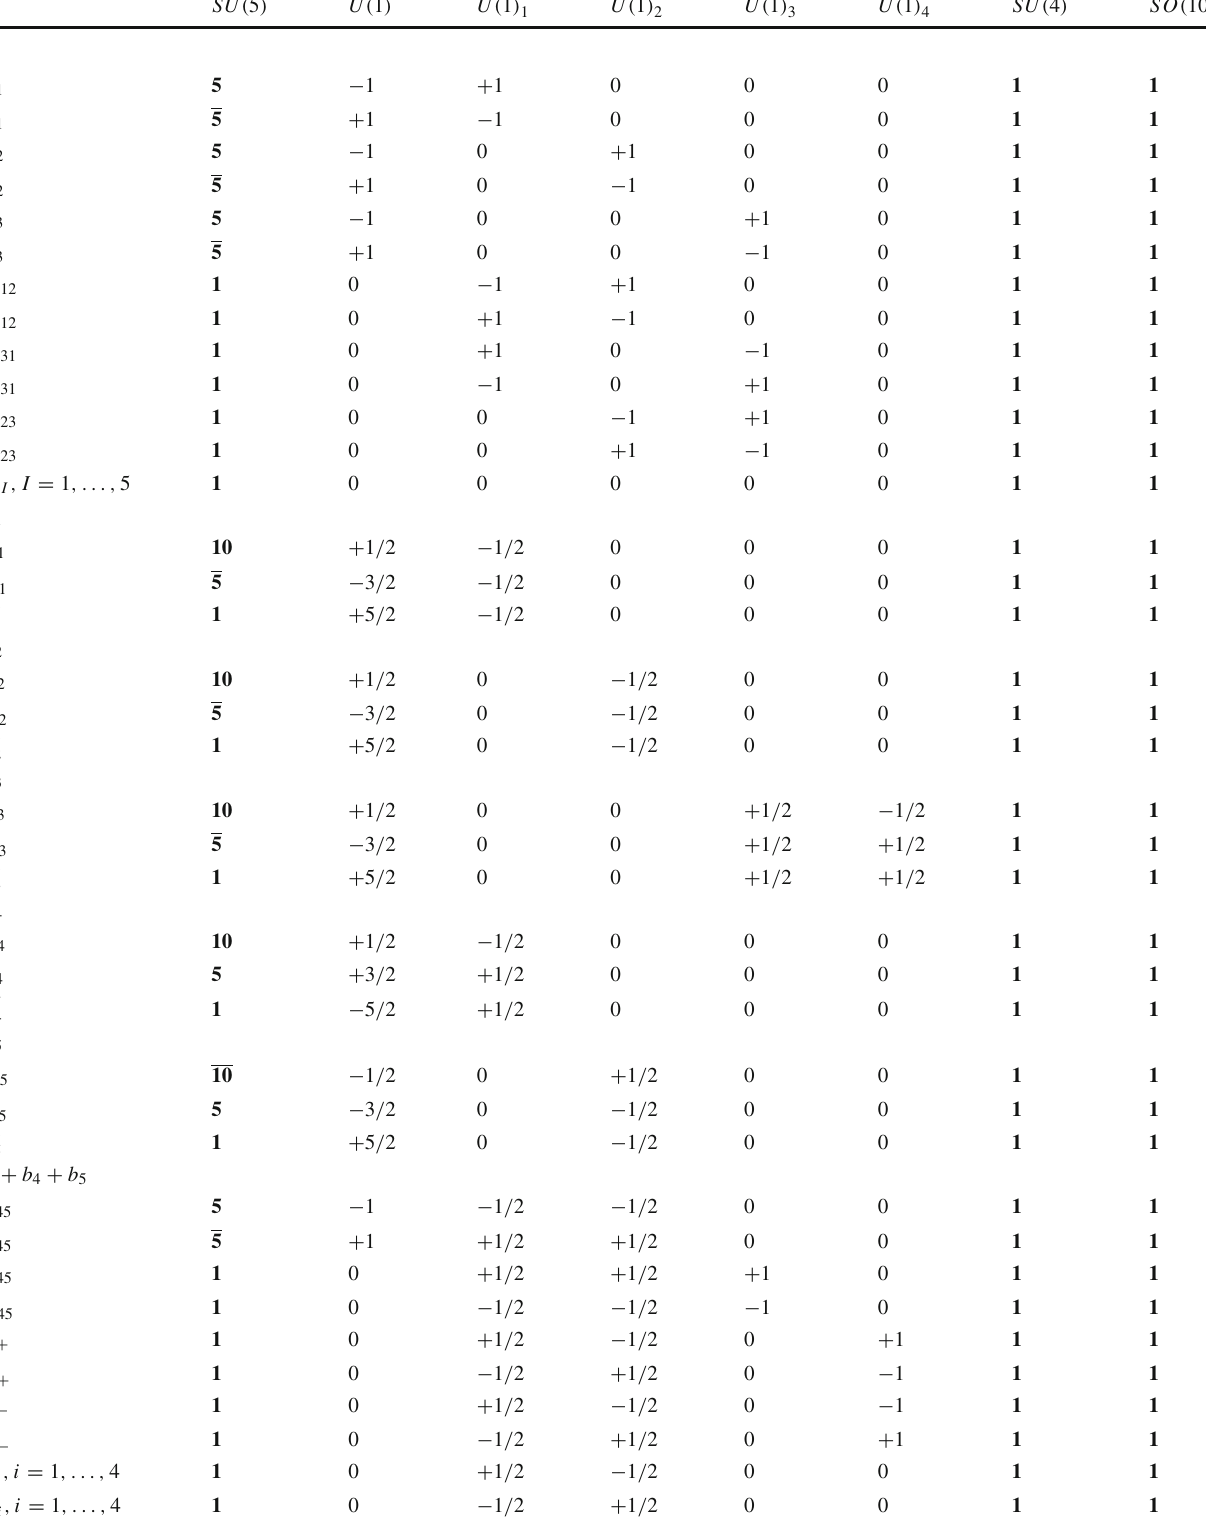
Table 2 “Observable” sector massless matter states and their SU ( 5 ) × U ( 1 ) × U ( 1 ) 4 × SU ( 4 ) × SO ( 10 ) quantum